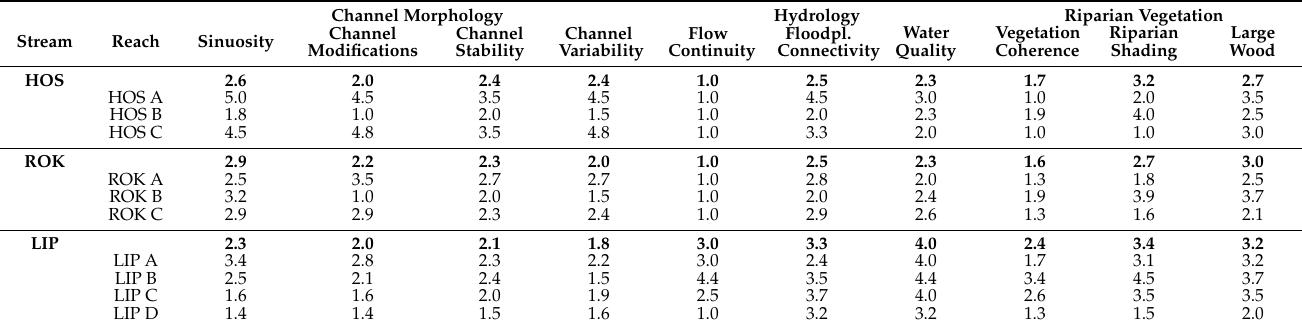
Table A2. Assessment of qualitative parameters by stream and